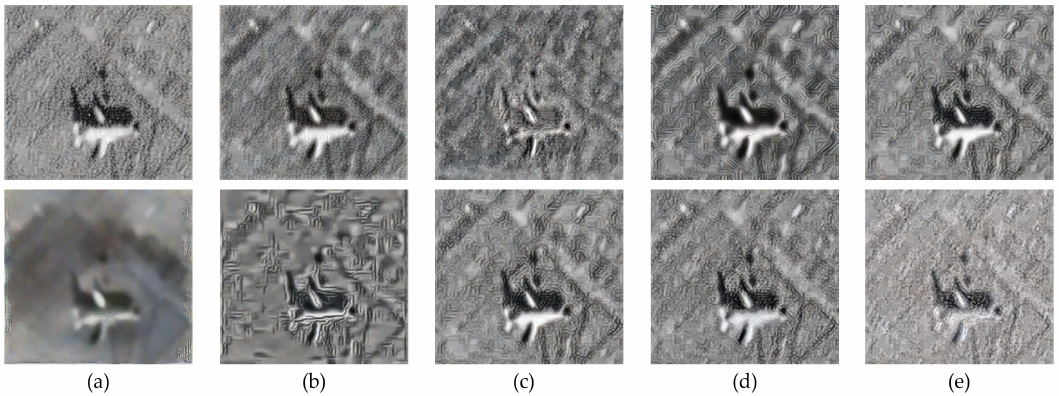
Figure 7. Generated images using different CR blocks as loss. ( a – e ) are the ST images obtained by calculating the losses using CR1–CR5, respectively. The first row is the result of changing content loss, and style loss is changed in the second row.